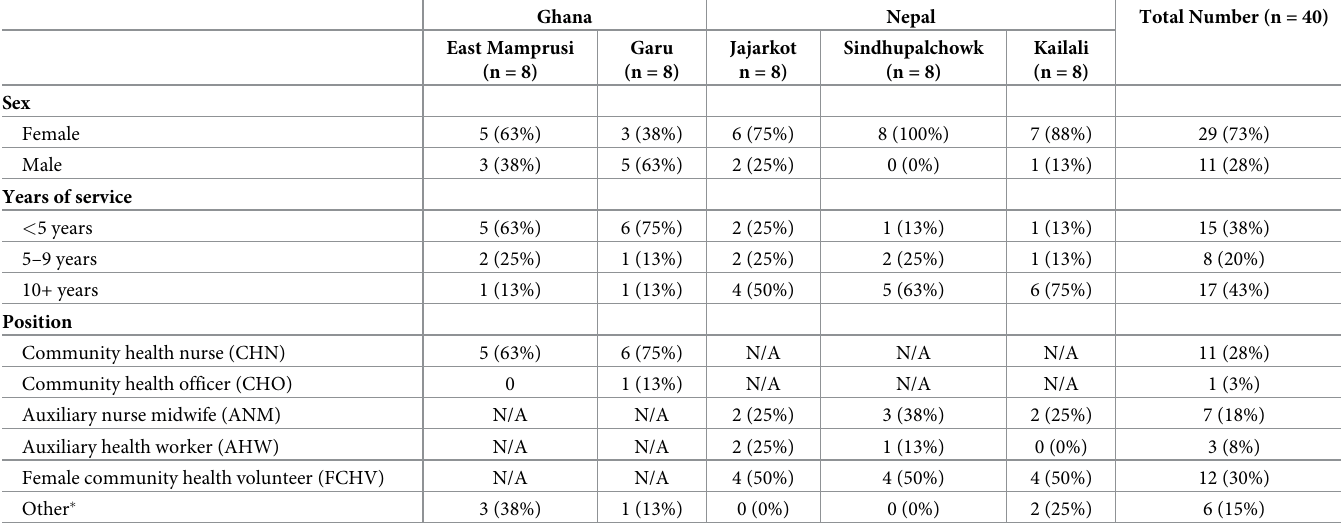
Table 2. Characteristics of health workers